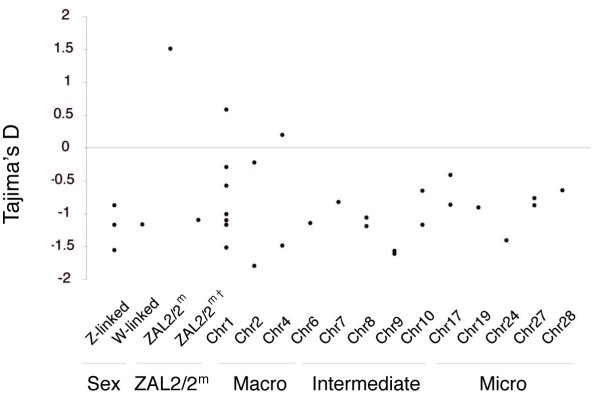
Tajima's D values across the sparrow genome. The ZAL2/2m data point represents data from within the inversion on both chromosome arrangements, while the ZAL2/2m† represents Tajima's D for outside the inversion on white-throated sparrow chromosome 2. Note that the chromosomes labeled as Chr refer to the predicted orthologous chromosome in chicken.